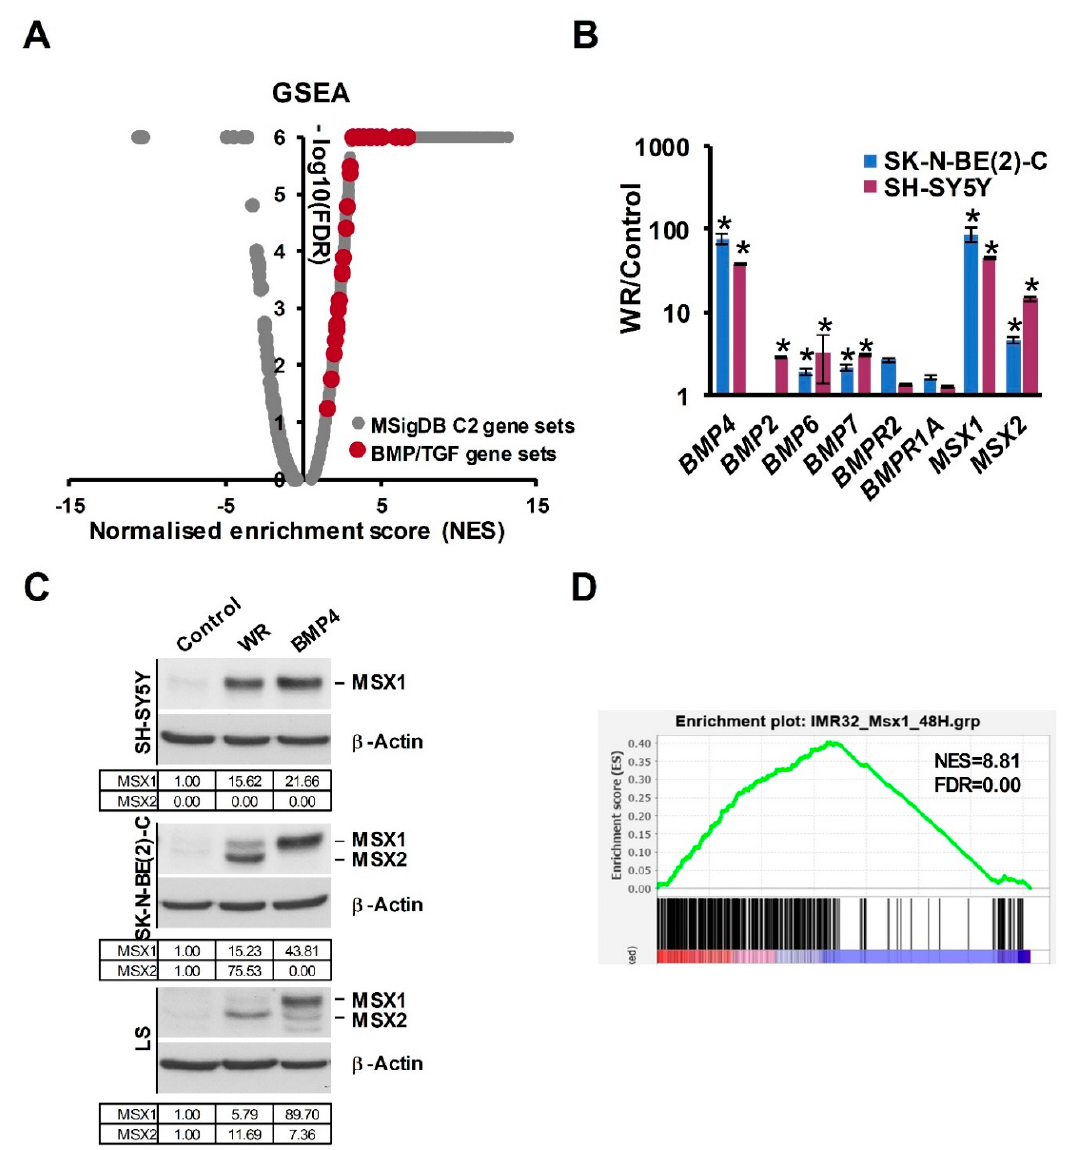
Figure 1. Convergence of Wnt and BMP pathways in NB. ( A ) GSEA Volcano plot on RNA-seq data of Wnt3a/Rspo2 (WR) induced SK-N-BE(2)-C cells (ERP023744) with C2 group of gene sets (Molecular Signatures Database, Broad Institute), highlighting upregulation of BMP and TGF- β sets, shown in red. ( B ) Genes coding for BMP ligands, receptors and BMP target genes MSX1 and MSX2 were upregulated by 72H Wnt3a/Rspo2 treatment in SK-N-BE(2)-C and SH-SY5Y cells as detected by qPCR. Statistically significant differences ( p < 0.05) are indicated by asterisks ( n = 3). ( C ) Western blot of neural crest master regulators MSX1 and MSX2 induction by both Wnt3a/Rspo2 and BMP4 treatment in neuroblastoma cells after 72-96H treatments. (representative of n = 2). Quantification relative to the control samples, after normalization to the loading controls, is shown in the tables. ( D ) GSEA showing upregulation of MSX1 target genes (GSE16481, 48H induction) in WR-treated SK-N-BE(2)-C.